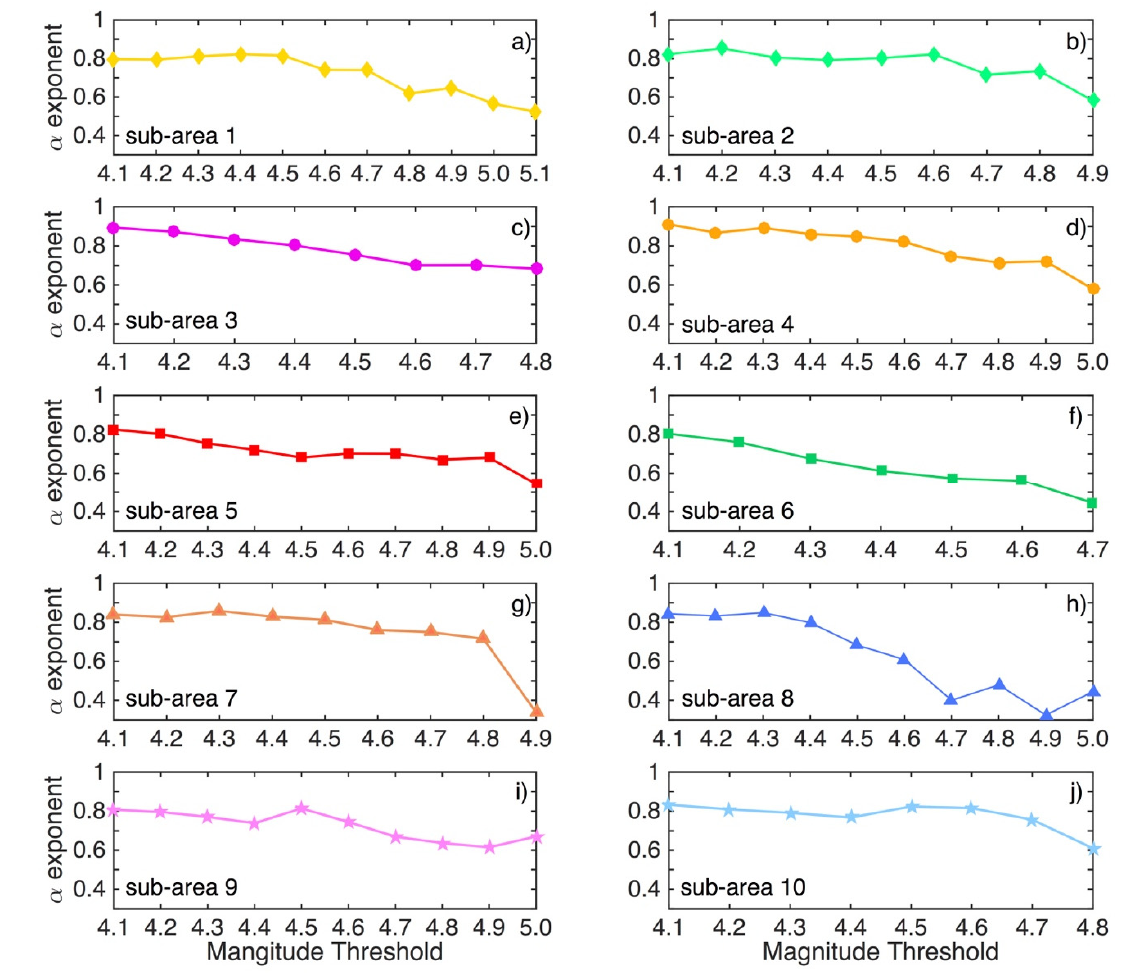
Figure 6. Exponent α of Detrended Fluctuations Analysis as a function of M thr for the 10 sub-areas (subplots a – j ). Table 3. MLE parameters estimates, 95% confidence intervals, log-likelihood values calculation, Akaike and Bayesian Information Criteria calculated values (AIC and BIC, respectively), along with the estimated p -values of the Anderson–Darling Goodness of Fit test for the four applied statistical distributions on the statistically independent interevent times data, ∆ T , of the sub-areas 1 to 5.